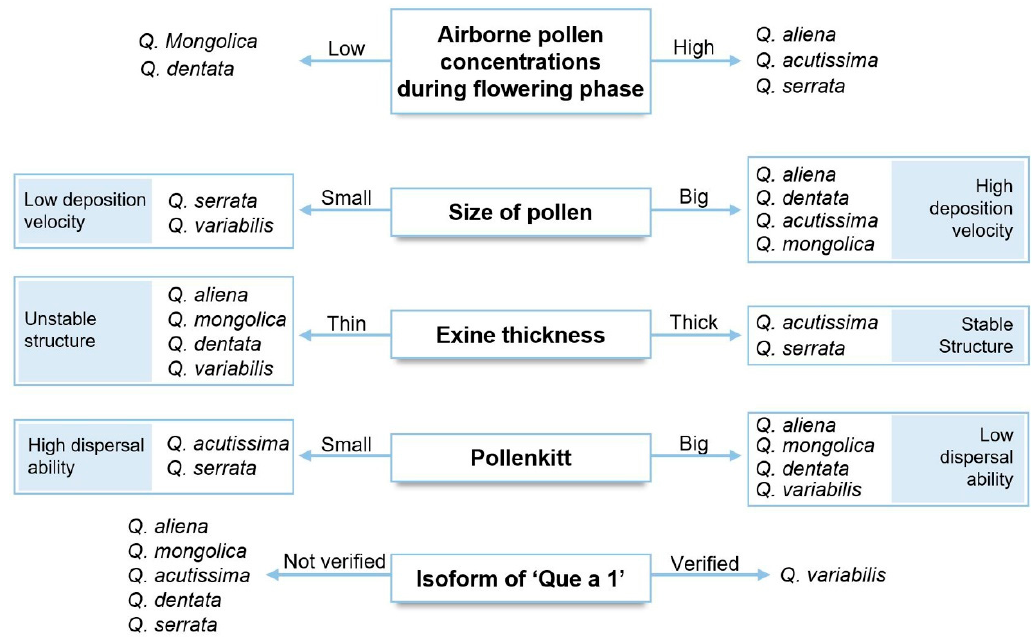
Figure 9. E ff ects of flowering phenology and pollen characteristics on Quercus pollen Figure 9. Effects of flowering phenology and pollen characteristics on Quercus pollen allergy.